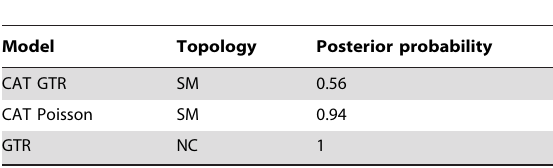
Table 4. Posterior probability of the topologies recovered by different models using Phylobayes (SM: scleractinian monophyly, NC: naked